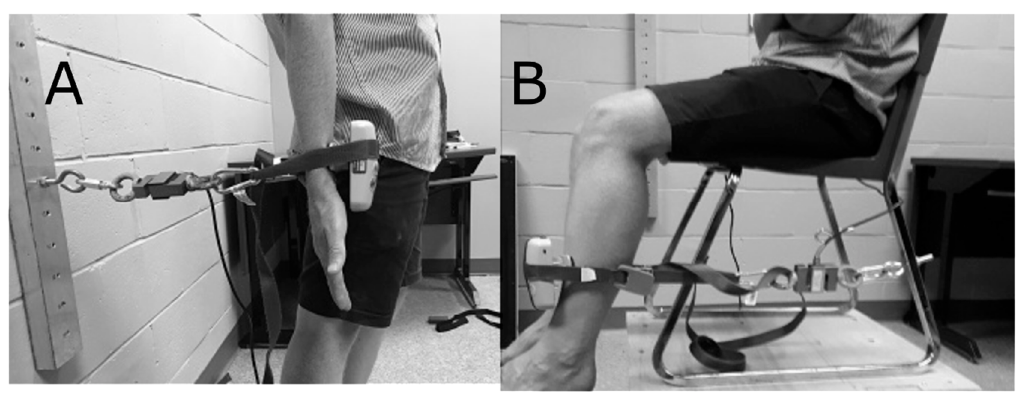
Figure 1. Experimental setup for simultaneously measuring all methods of force measurements for the upper; ( a ) and lower; ( b )